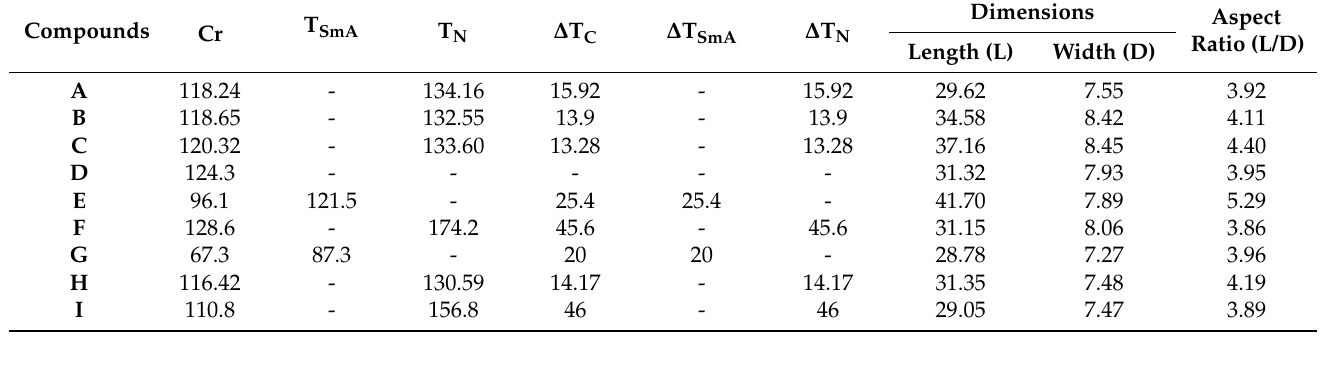
Table 3. Mesomorphic parameters for heating cycle (°C), the calculated dimensions (Ǻ), and aspect ratios of A , B , C , D , E , F , G , H , and I compounds.